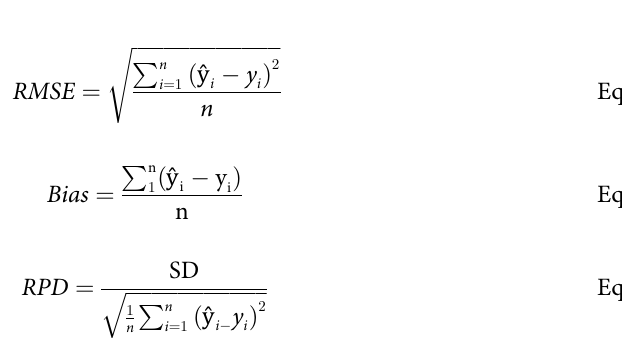
SD ffiffiffiffiffiffiffiffiffiffiffiffiffiffiffiffiffiffiffiffiffiffiffiffiffiffiffiffi